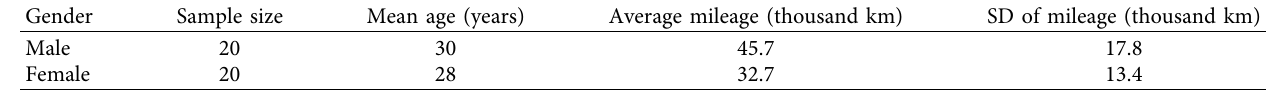
Table 1: Main effect test table.